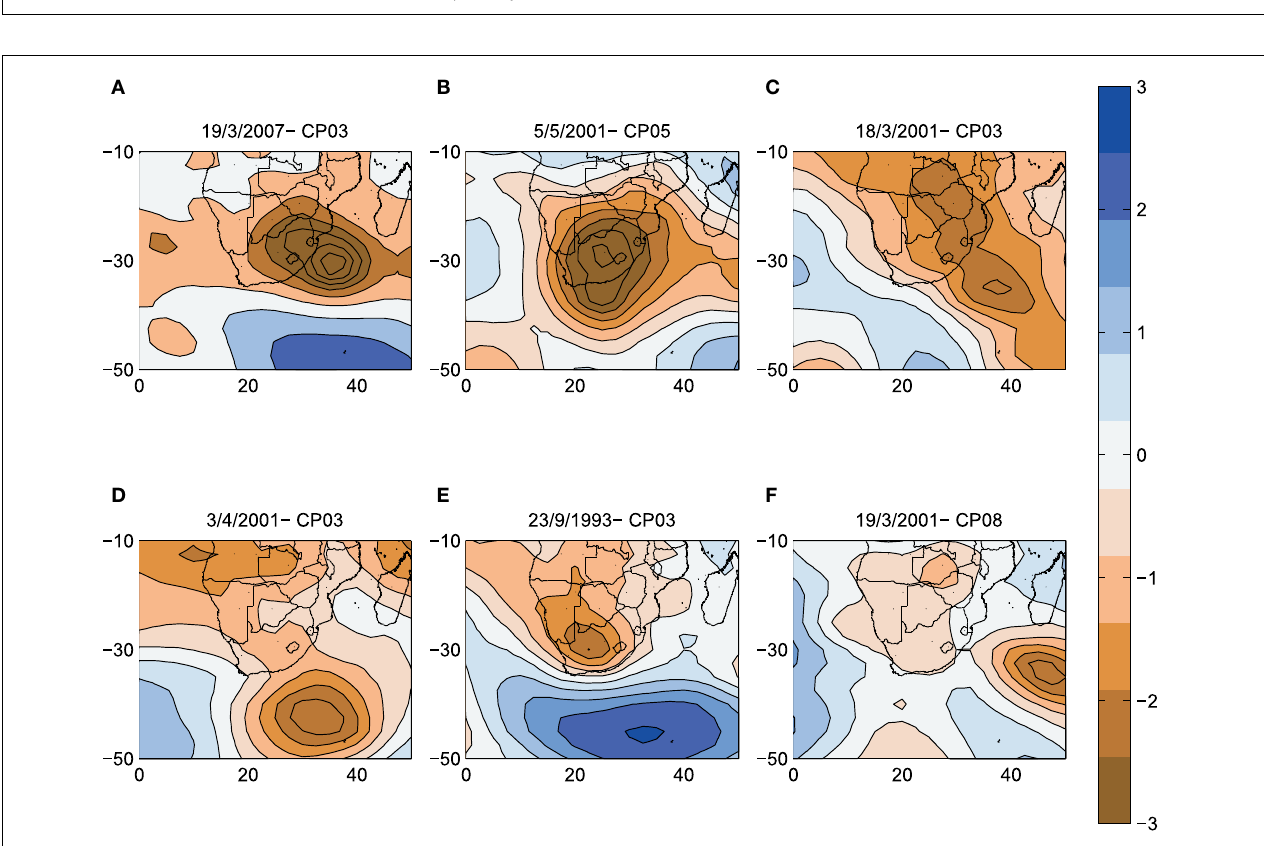
FIGURE 8 | CP’s associated with the six largest significant wave heights for the dates (A) 19/3/2007, (B) 5/5/2001, (C) 18/3/2001, (D) 3/4/2001, (E) 23/9/1993, and (F) 19/3/2001.